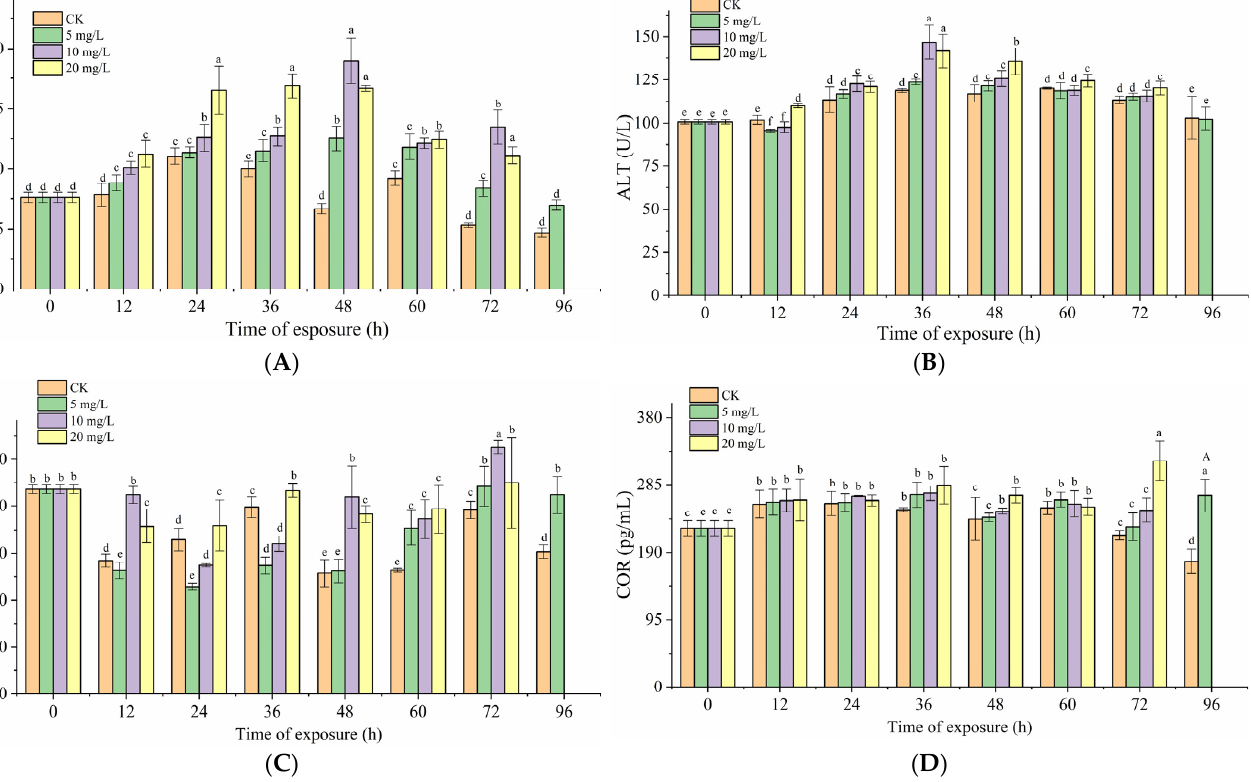
( B ) Figure 2. Changes in humoral immune parameter ( A ) IgM and ( B ) LZM levels in pearl gentian grouper exposed to various nitrite concentrations over 96 h. Data are means ± SD. Different lowercase letters indicate that there are significant differences among groups ( p < 0.05). 3.4. Effects of Nitrite Exposure on Oxidative Stress in Grouper